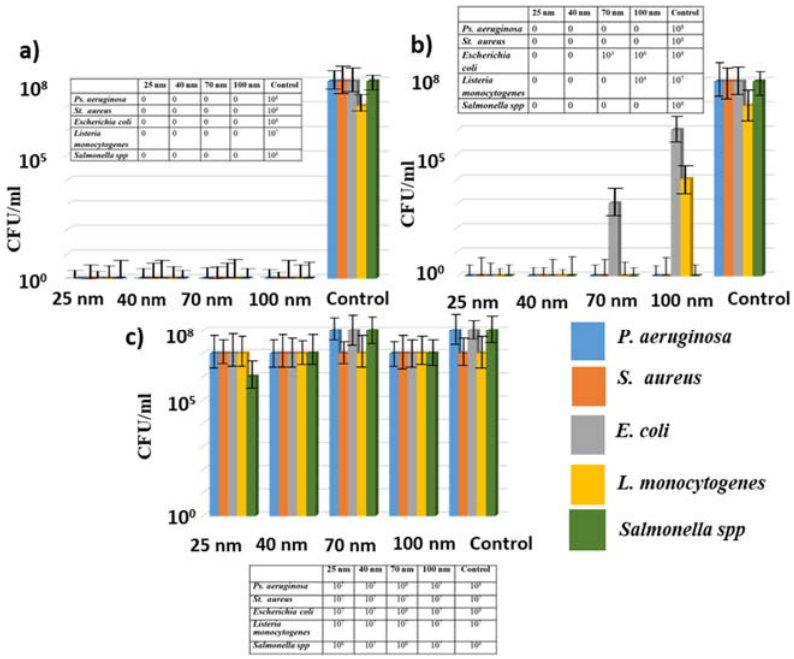
Figure 6. Antibacterial effect (in CFU/mL) of Cu NPs ( a ); Ag NPs ( b ); Au NPs ( c ) transferred from metal films of various thicknesses on biofilms of clinical isolates; inserts: tabular data.